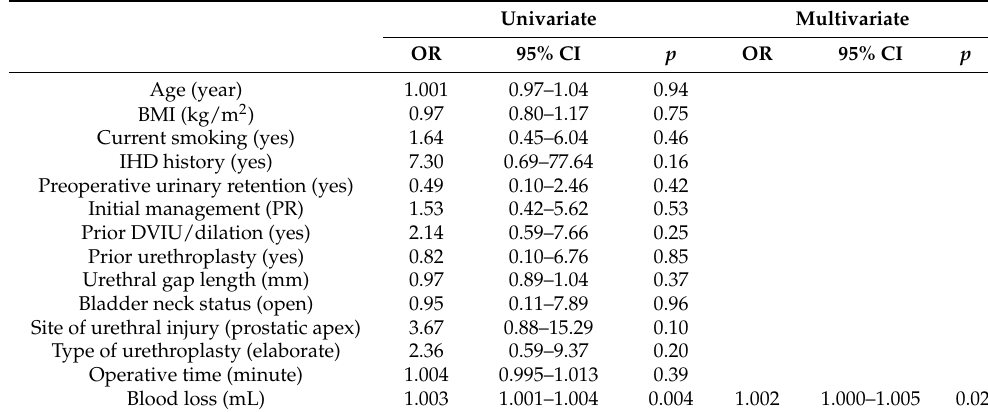
Table 5. Logistic regression analysis for predictors of failed